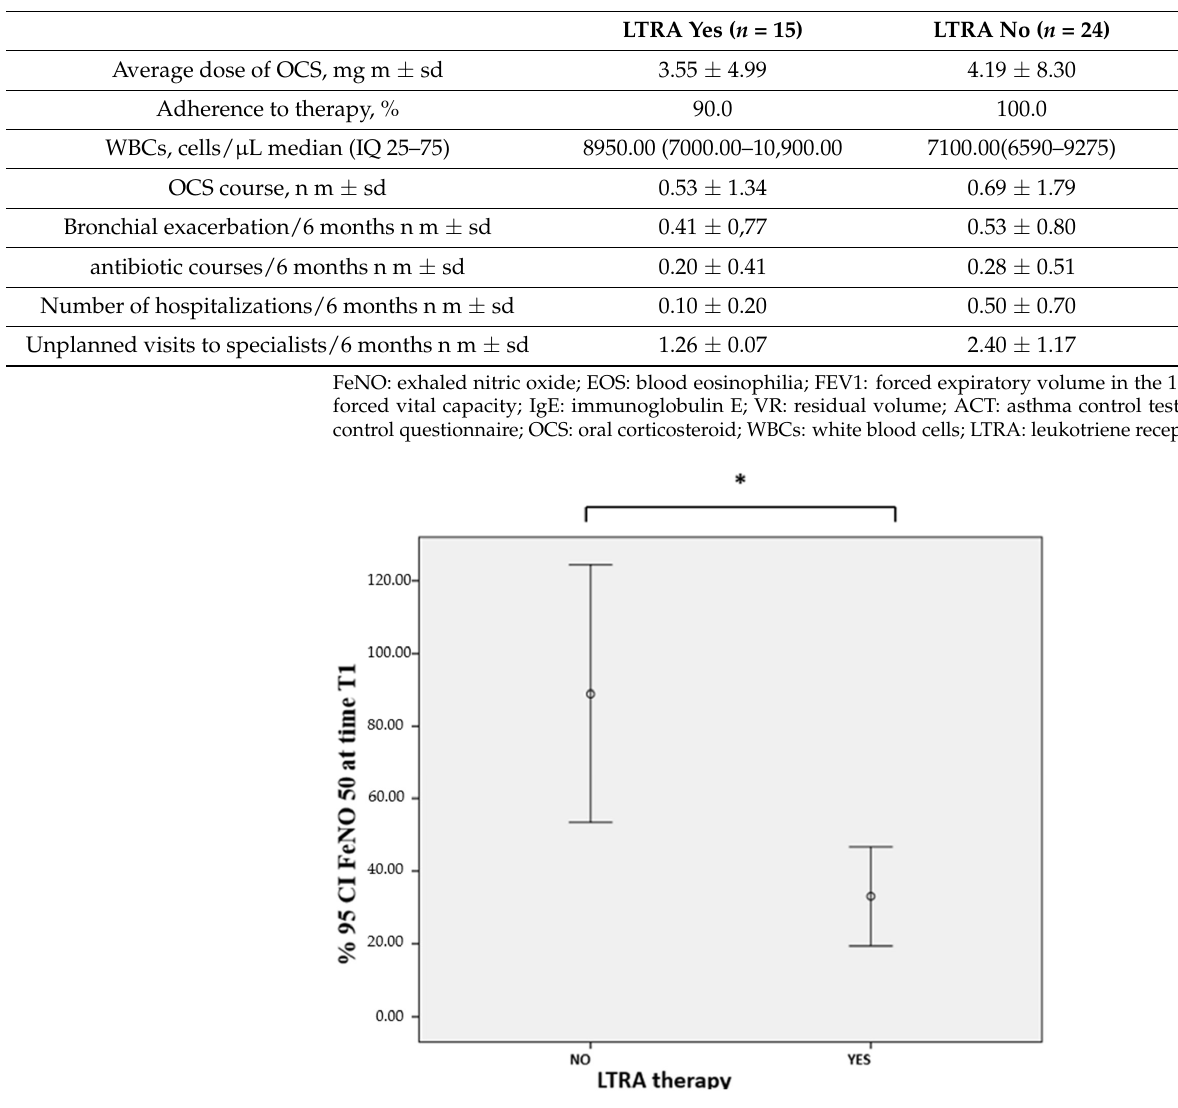
Figure 1. FeNO 50 at time T1: comparison based on LTRA therapy. FeNO: exhaled nitric oxide; LTRA: leukotriene receptor antagonist. *: statistically significant difference; LTRA therapy vs. no LTRA therapy: 30.83 ± 24.30 vs. 88.93 ± 77.96; p =